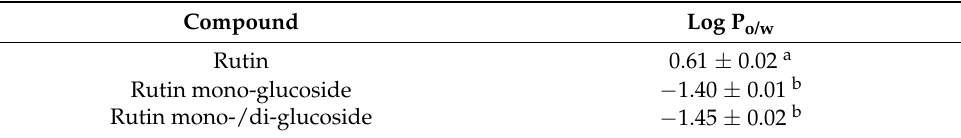
Table 1. Octanol/water partition coefficients of rutin and rutin glycosides.